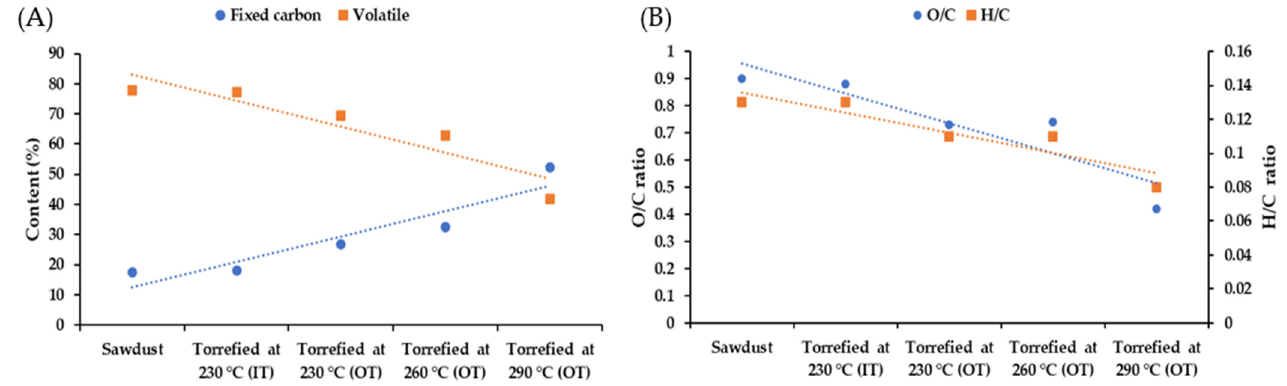
Figure 6. Proximate analysis ( A ) and oxygen/carbon, hydrogen/carbon ratios of wood sawdust before and after torrefaction ( B ).